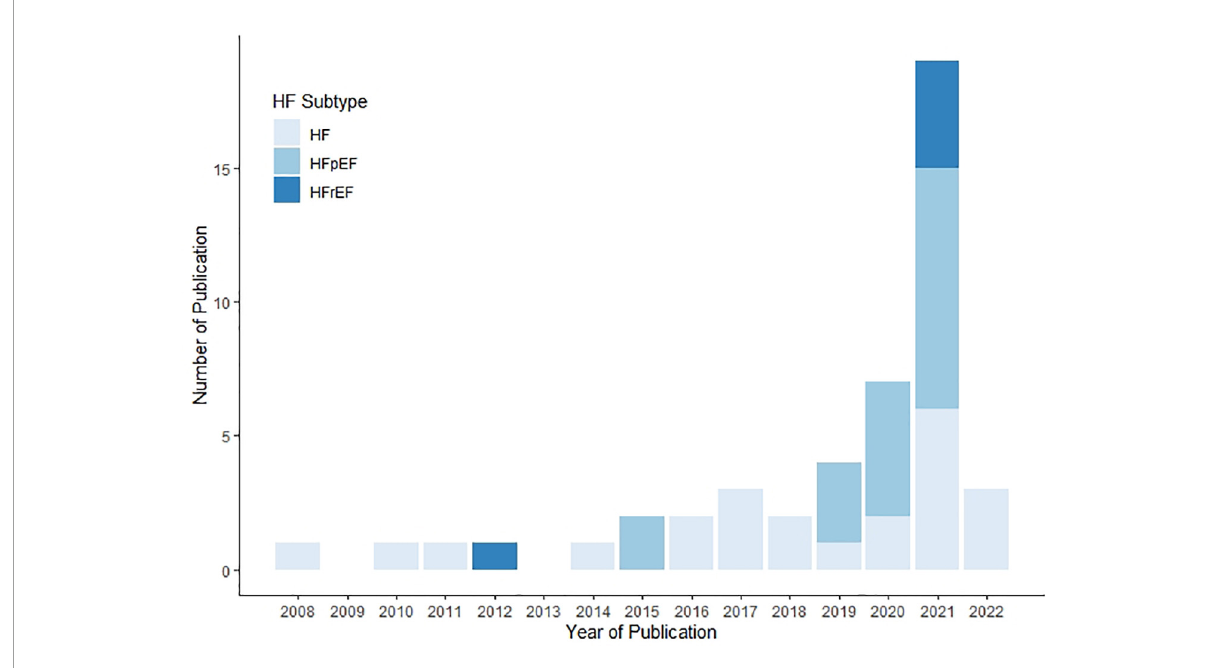
FIGURE2 Number of publication per year by HF sub-types.